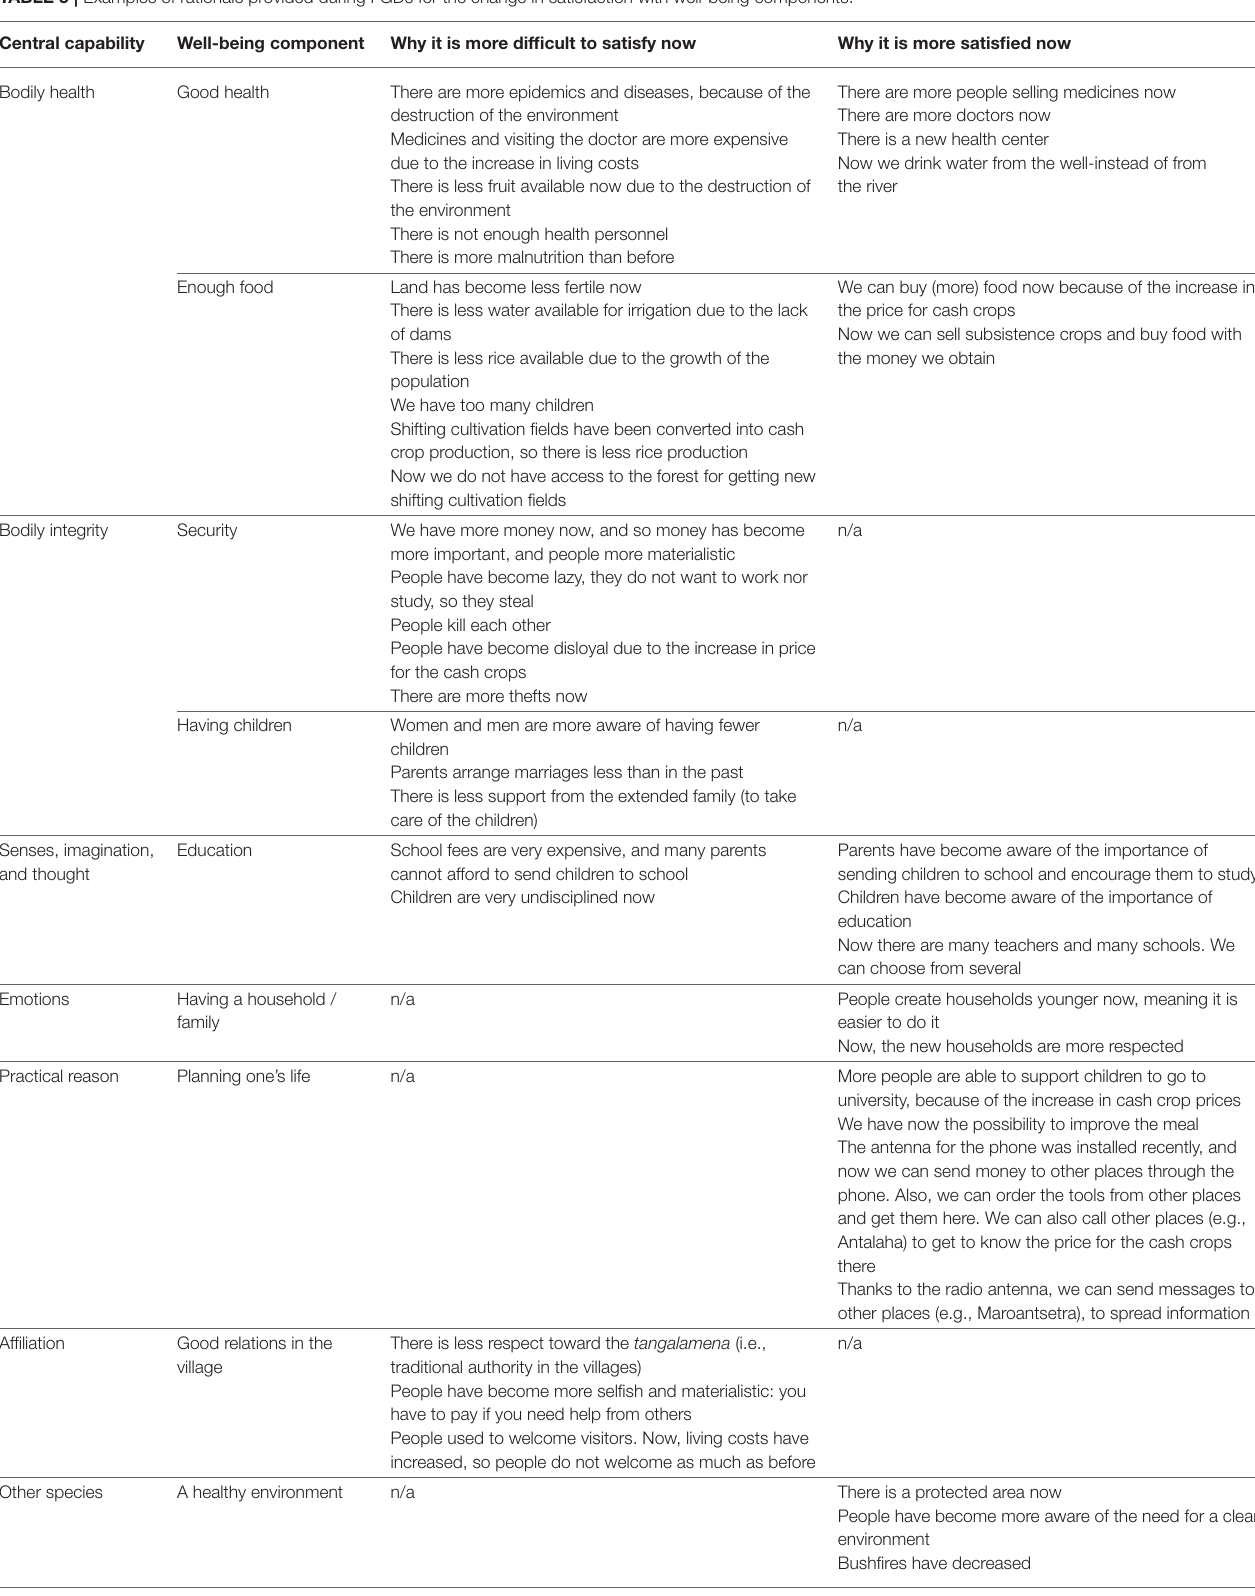
TABLE 5 | Examples of rationale provided during FGDs for the change in satisfaction with well-being components. Central